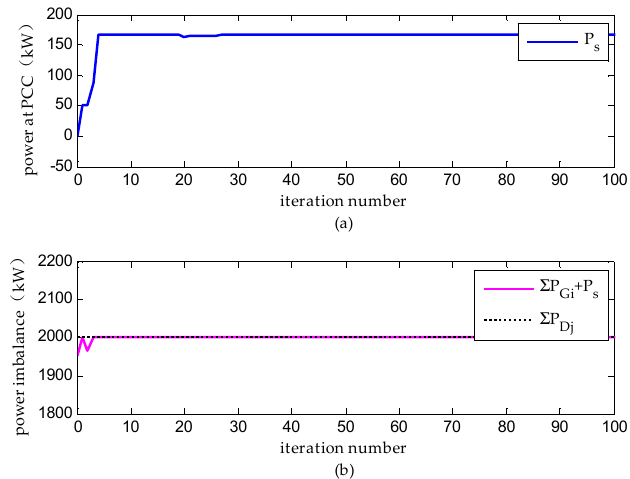
Figure 8. The simulation of power balance in Scenario C . ( a ) Power at PCC; and ( b ) The variation of power imbalance.